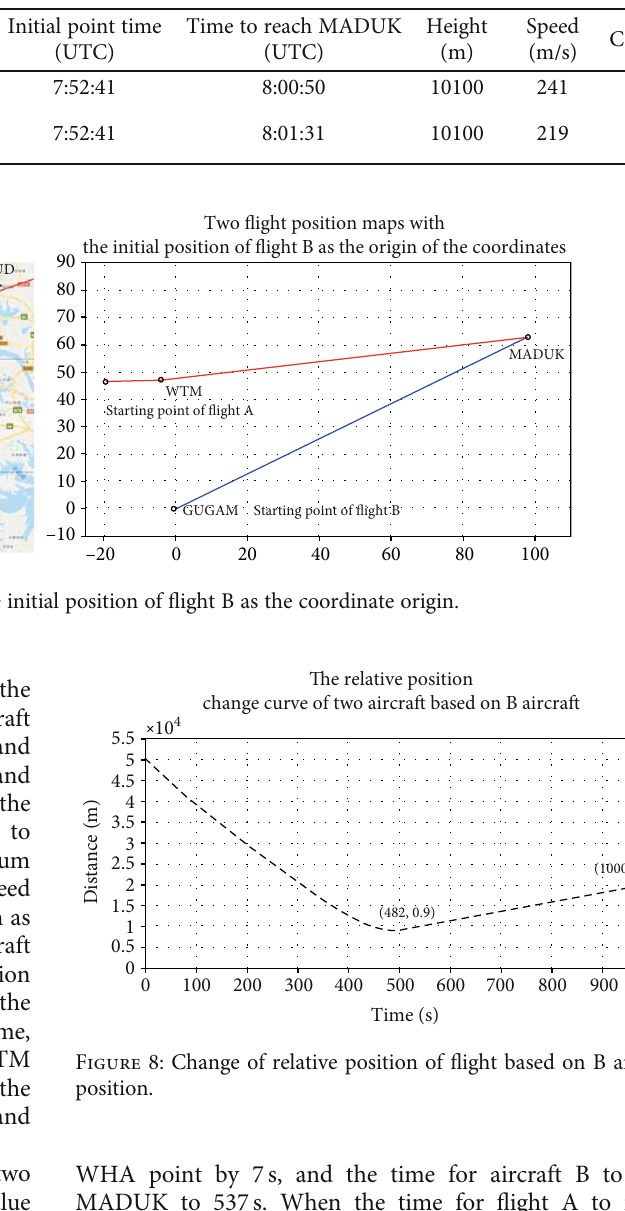
Table 3: Flight plan information.